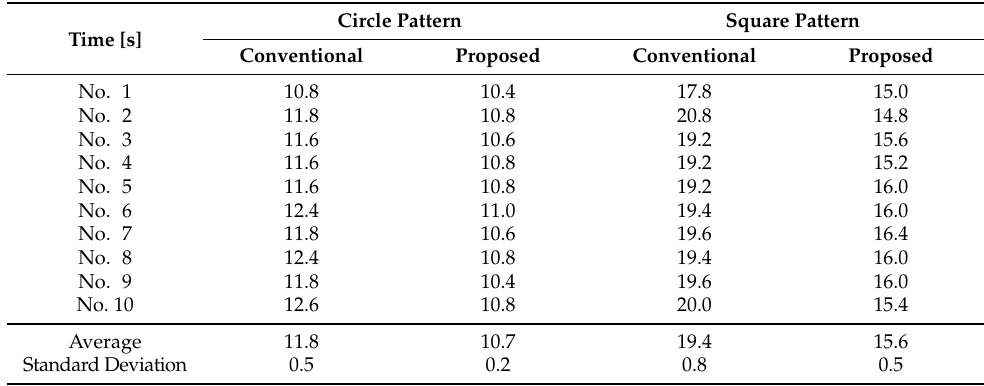
Table 6. Time required to complete the trajectory. Circle Pattern Square Pattern Time [s] Conventional Proposed Conventional